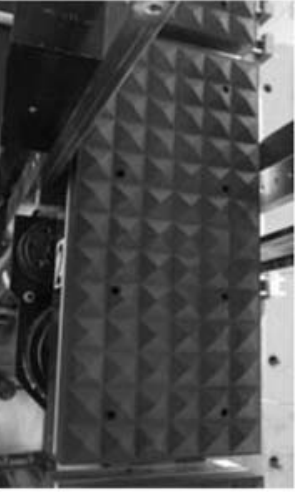
Fig. 4. Programmer. The pyramidal texture on the front surface is designed prevent an overly-abrupt pulse initiation